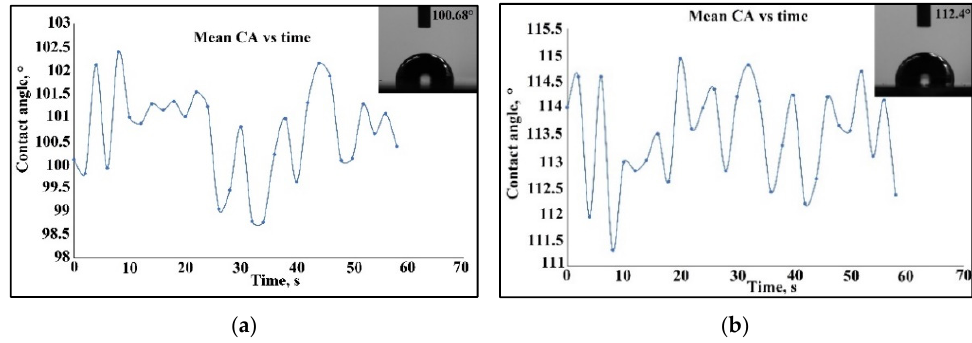
Figure 15. The contact angle measurement of the samples coated with a composite film of 75%Ta 2 O 5 and 25%ZnO by e-gun technology: ( a ) Sample S6 of the Co–Cr alloy fabricated via the DMLS process; ( b ) Sample S5 of the cast 304L stainless steel.